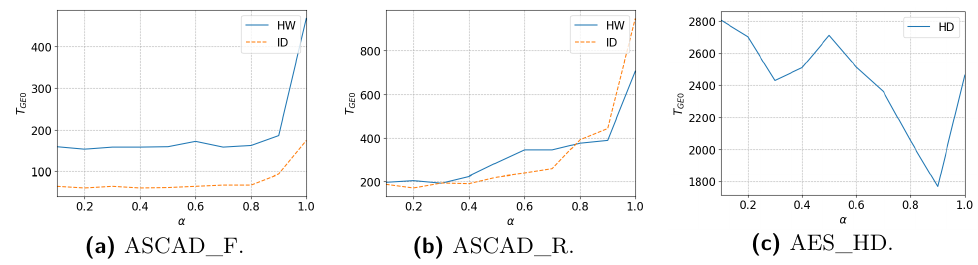
Figure 6: The effect of α